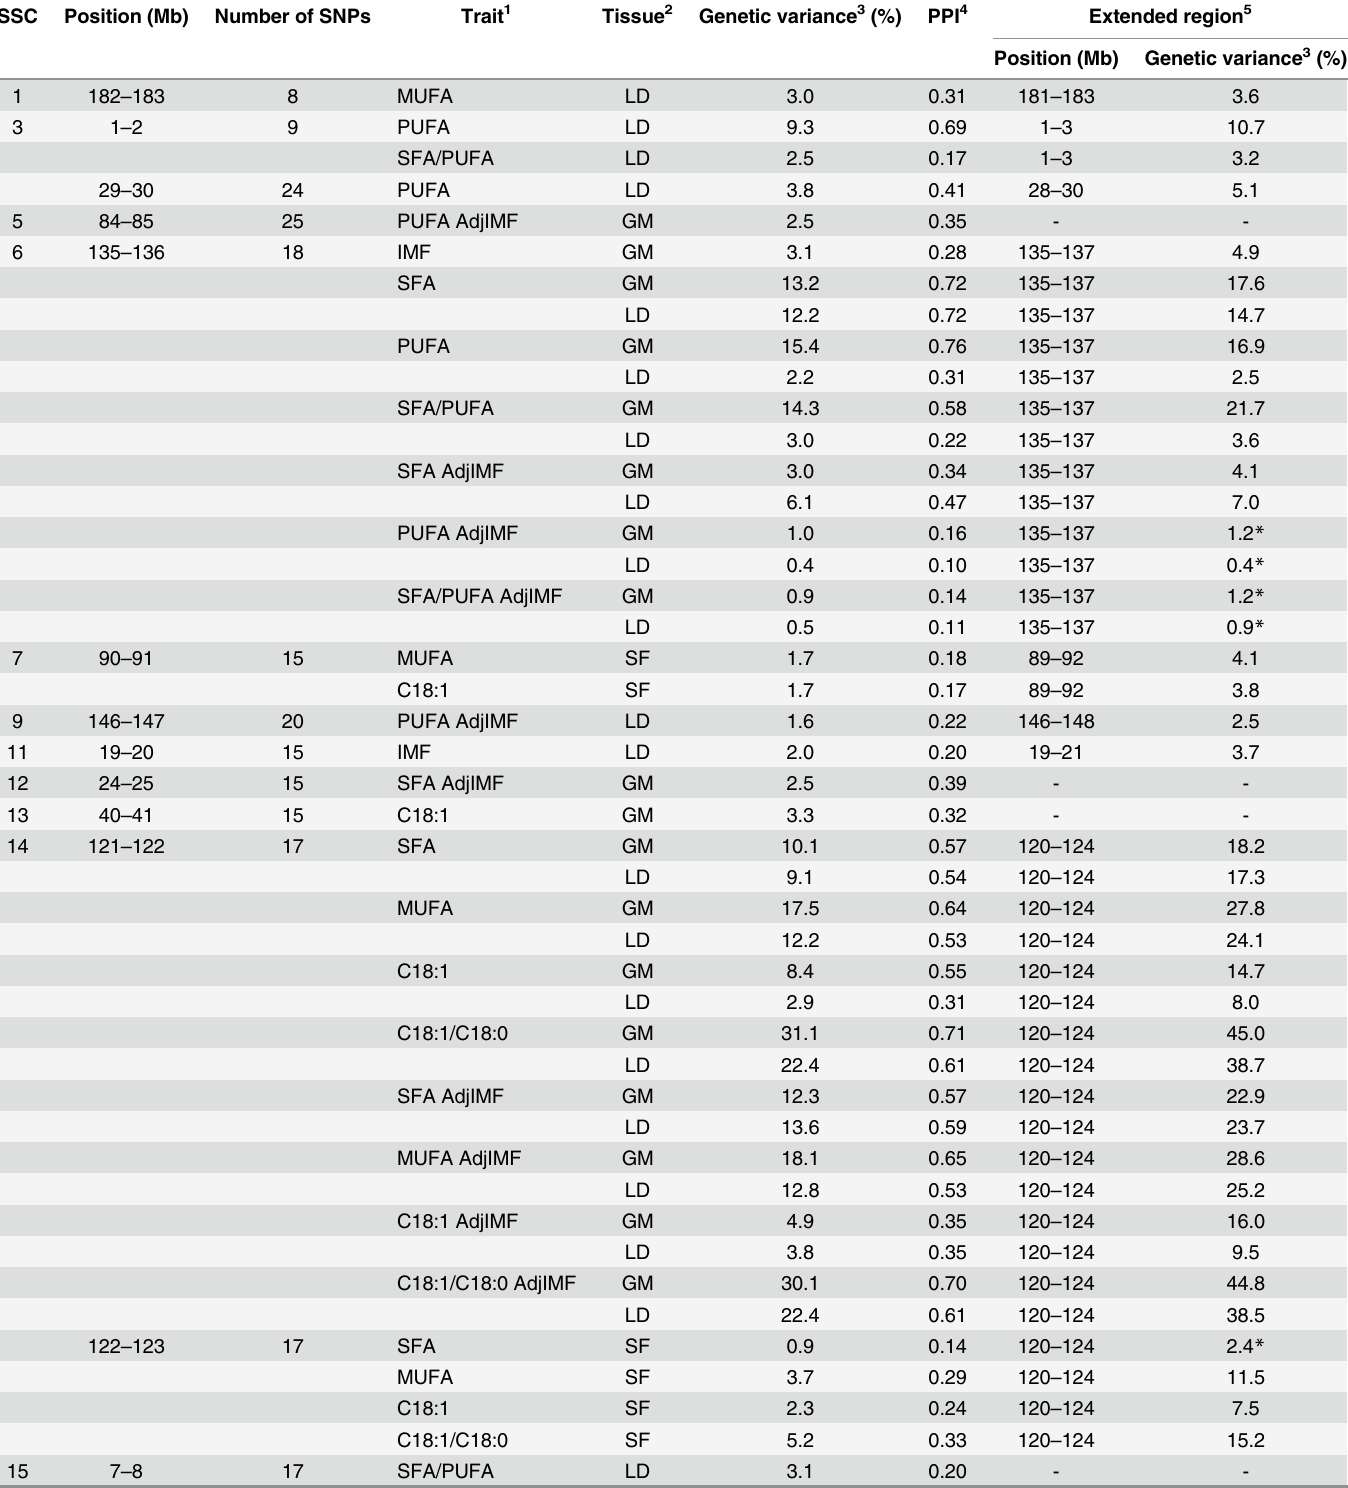
Table 2. Candidate regions for intramuscular fat content and fatty acid composition